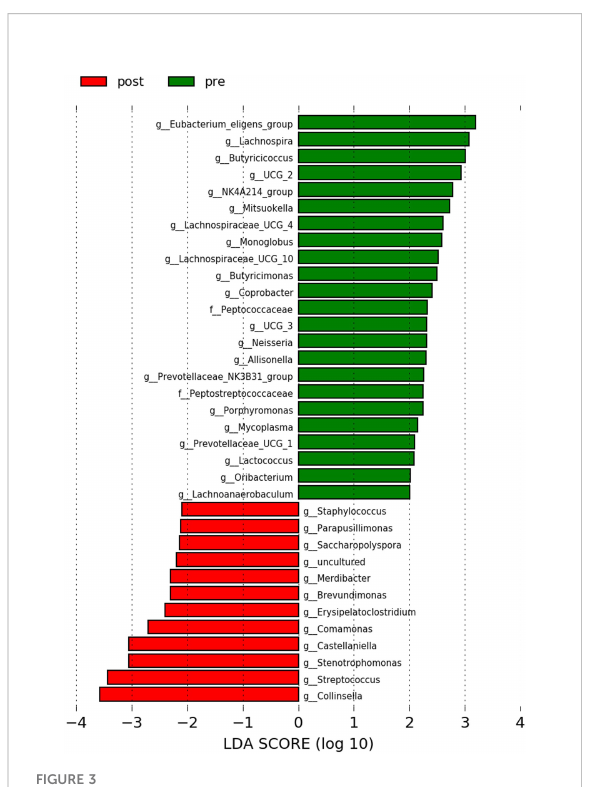
FIGURE 3 LEfSe analysis between pre-antibiotics and post-antibiotics groups. Histogram of LDA scores is shown as the results of LEfSe analysis for evaluating biomarkers with the statistical difference among groups. Only differentially enriched microbiota with LAD >2.0 and p-value <0.05 were